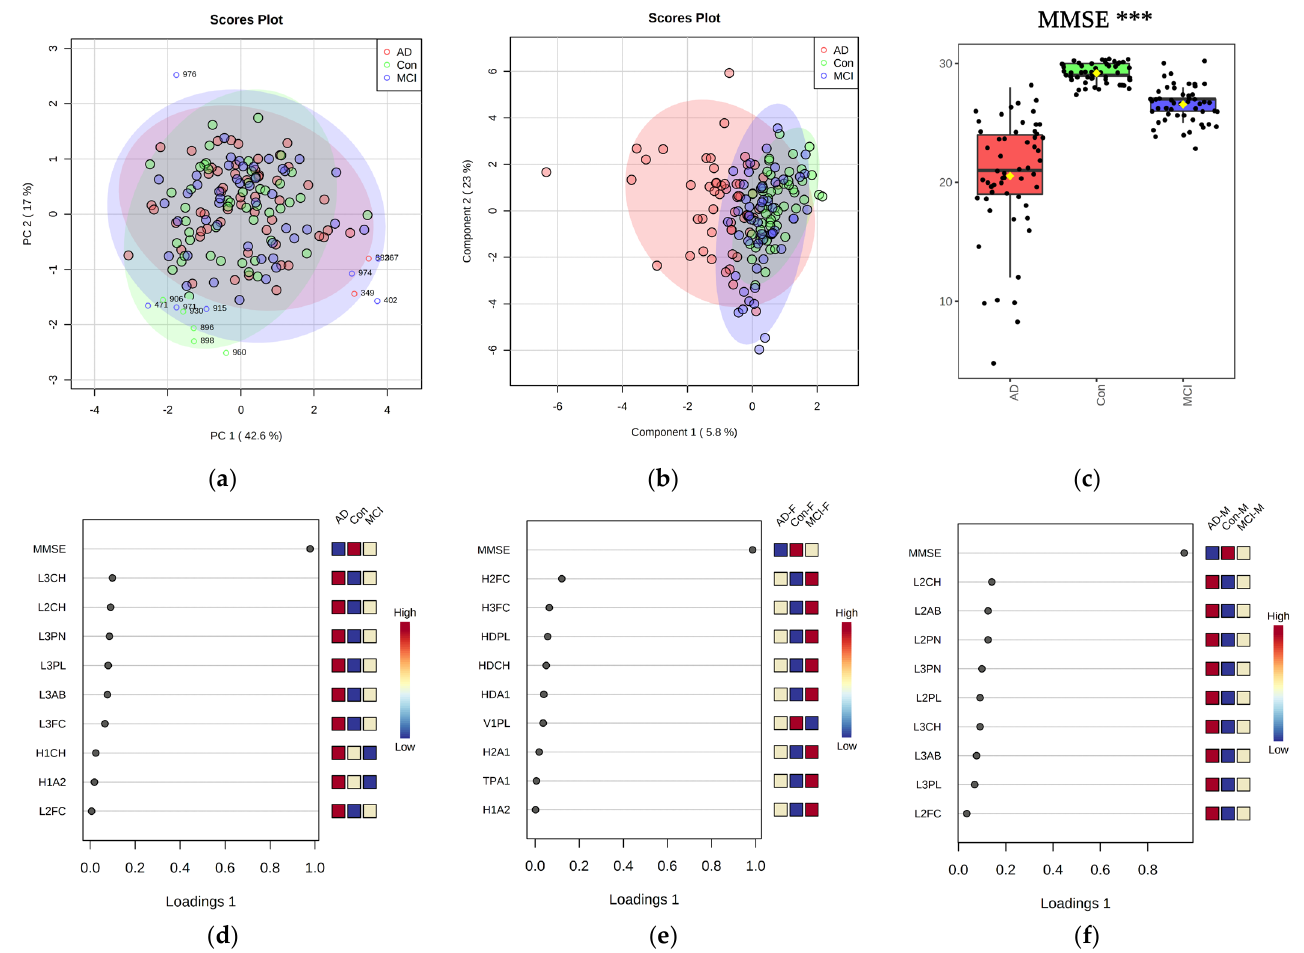
Figure 1. Multivariate analysis of combined NMR lipoprotein and clinical parameters plotted via PCA scores (Panel ( a )), outliers shown), sPLS − DA regression model analysis scores plot (Panel ( b )). The data displayed include the MMSE score and age (Panel ( c )). Additionally, the significance of MMSE is further illustrated by the top 9 lipoprotein data variables ranked by component 1 significance of the sPLS − DA regression model analysis loadings plot (Panel ( d )), which are L3CH, L2CH, L3PN, L3PL, L3AB, L3FC, H1CH, H1A2, and L2FC. sPLS − DA regression model analysis of three patient group comparisons separated by gender criterion is shown (Panel ( e , f )). Significance: *** p < 0.001. F − female. M − male.